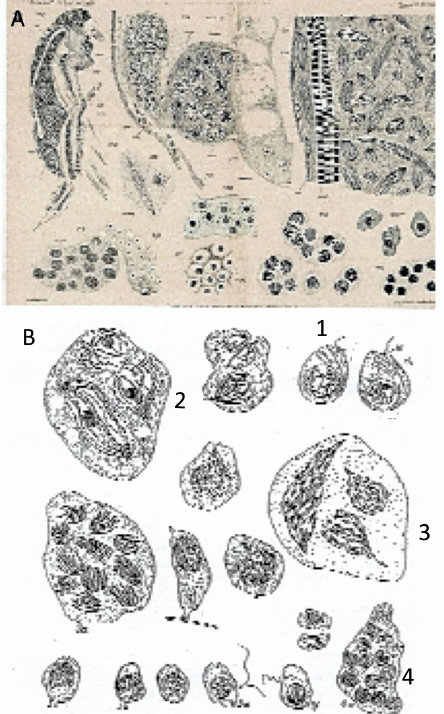
Figure 6. Miscellaneous syndinialean coelomic parasites of copepods. ( A ). At the top, Paracalanus parvus copepod invaded by a Syndinium plasmode with nuclei containing five chromosomes X = 150. At the bottom, at right, sporocytes with 5 chromosomes visible X = 180. Reproduction of plate XIV from the Chatton’s Doctorate Thesis, [7]. ( B ). Detail of plasmodia with dividing nuclei and dinospores (bottom). 1. Syndinium rostratum ; 2. S. corycoei ; 3. S. turbo ; 4. S. microsporum . X = 220. Reprinted/adapted with permission from